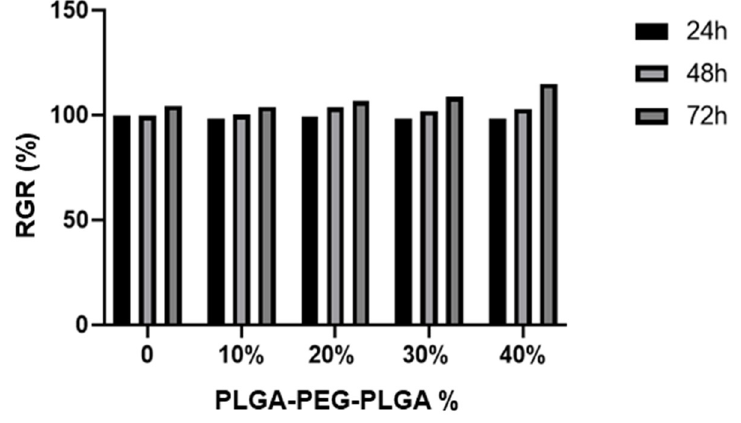
Figure 10. Relative growth rate of composite bone cement with different PLGA-PEG-PLGA temperature-sensitive hydrogel contents at different times.